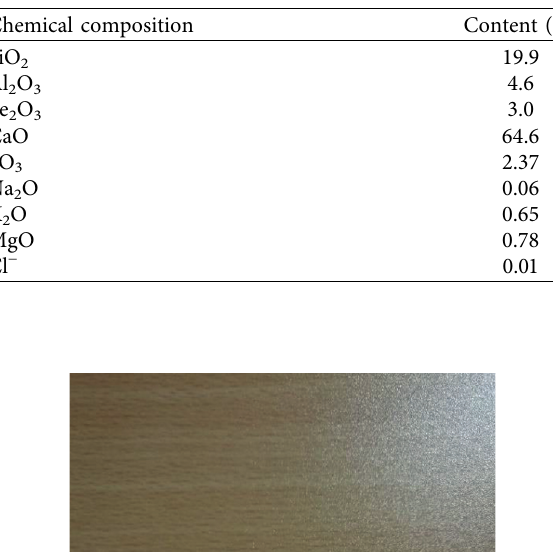
Table 1: Chemical composition of cement.